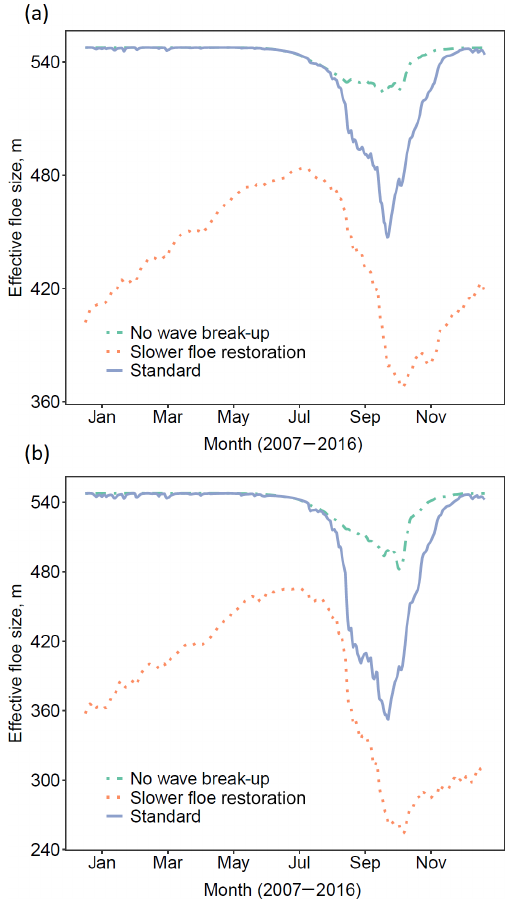
Figure 13. Daily variation in l eff over 2015 averaged over (a) re- gions with between 15% and 80% sea ice concentration on 31 Au- gust 2015 and (b) regions with between 15% and 30% sea ice concentration on 31 August 2015. The three simulations demon- strate l eff tendencies with respect to different processes. The plots show the evolution of l eff throughout the year for the standard sim- ulation (stan-fsd, blue solid), without wave break-up of floes (F, green dotted–dashed), and with a reduced floe size restoration rate in freezing conditions (K, orange dotted). Means for l eff and ice perimeter are taken as averages over the selected grid cells with each grid cell equally weighted. The plots show that a strong sea- sonal cycle in l eff can be observed, particularly in grid cells on the edge of the sea ice cover where waves are expected to have a partic- ularly strong